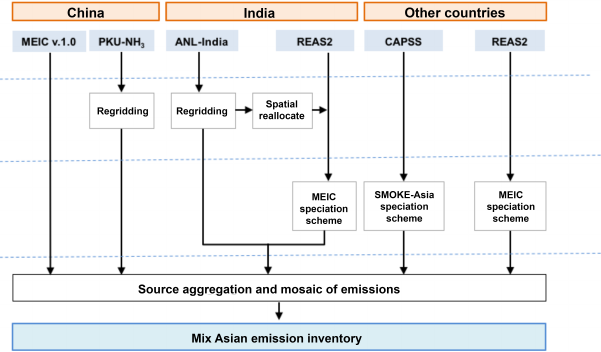
Figure 2. Schematic methodology of the MIX emission inventory